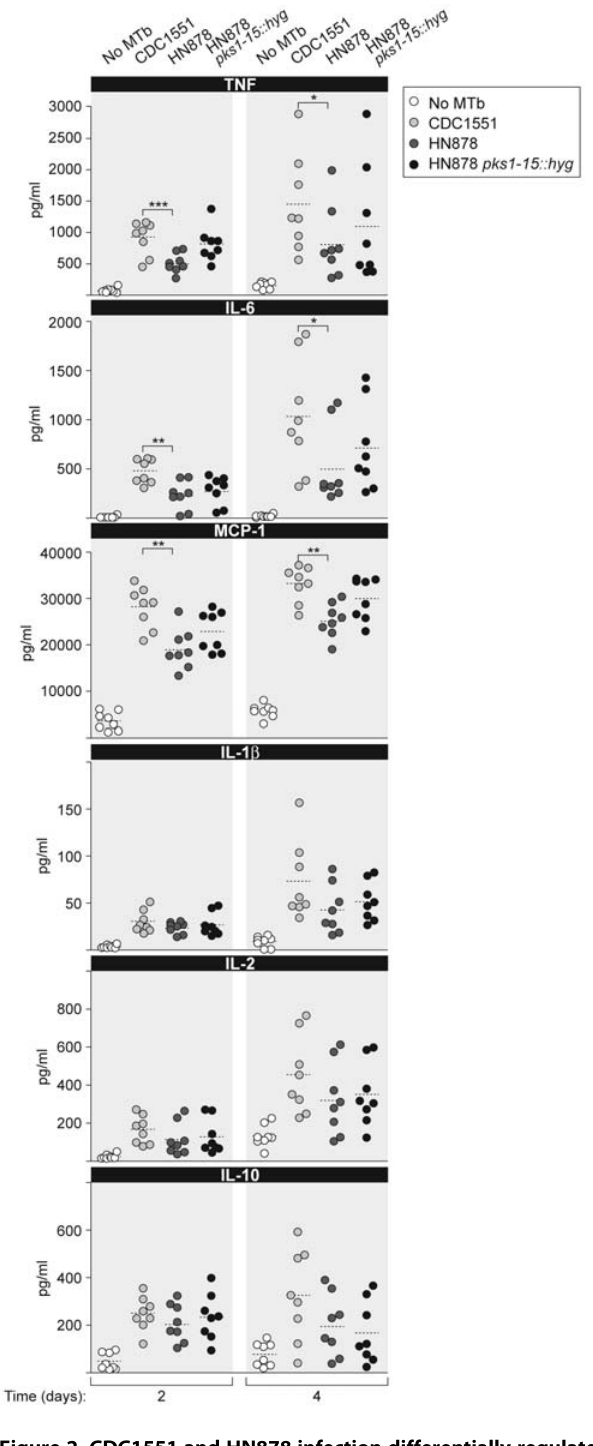
Figure 2. CDC1551 and HN878 infection differentially regulate TNF, IL-6 and MCP-1 in human PBMC . PBMC from eight different donors were infected in duplicate with the MTb strain CDC1551, HN878, or HN878 pks1-15::hyg for 2 or 4 days and levels of TNF, IL-6 and MCP-1 were assessed. Production of TNF, IL-6 and MCP-1 was significantly higher in CDC1551 infected cells as compared to HN878 infected cells (*p , 0.05; **, p , 0.01; ***, p , 0.005). Infection of PBMC with HN878 pks1-15::hyg non-significantly increased the production of these cellular factors as compared to infection with HN878. Expression of IL-1 b , IL-2 and IL-10 were also on average minimally higher in CDC1551 versus HN878 infected cells, but not significantly. doi:10.1371/journal.pone.0006116.g002 PLoS ONE |